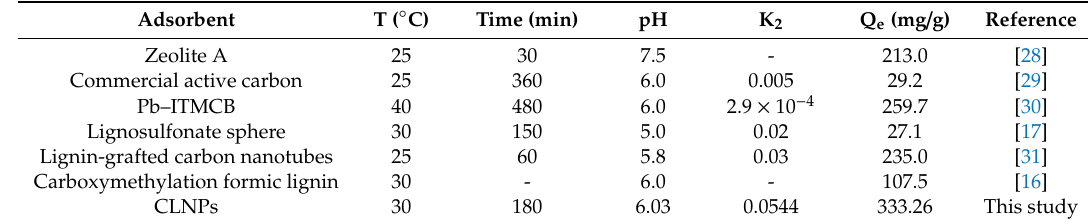
Table 2. Comparison of the lead adsorption capacity by CLNPs and other adsorbents.